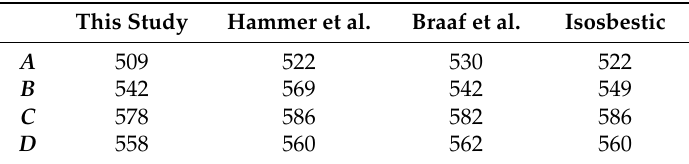
Table 1. Selected wavelengths for the oxygenation estimation